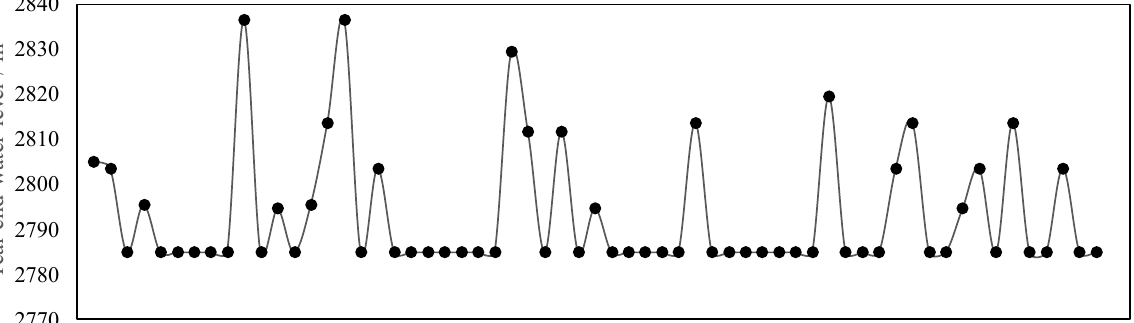
Figure 6. Variation of the optimal yearly drawdown level of the Lianghekou reservoir in each year.